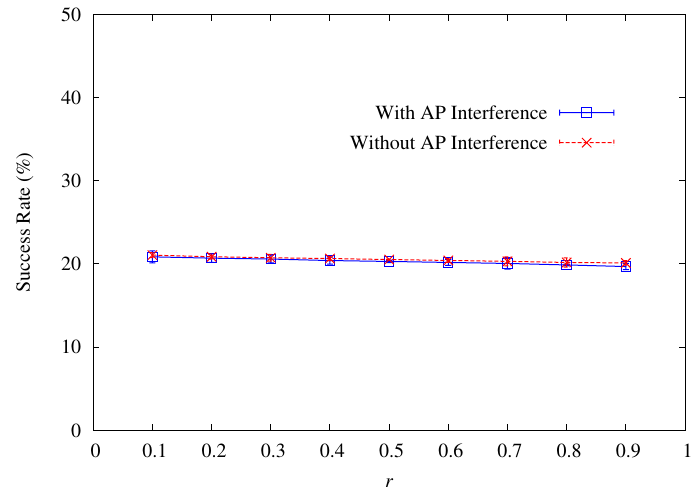
Figure 15. Impact of Wi-Fi AP interference on discovery success